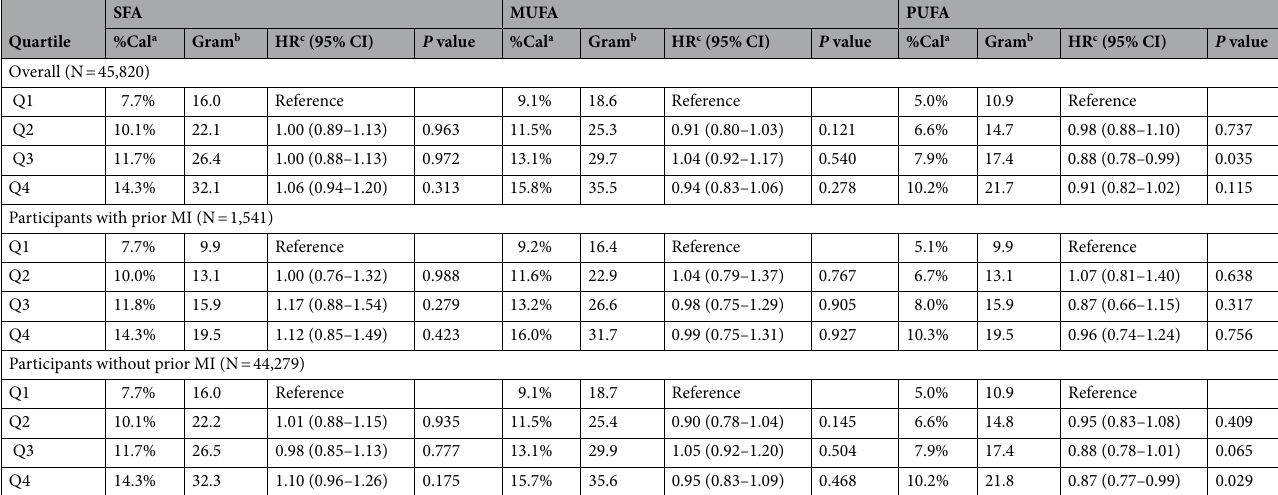
Table 3. Quartiles of the percentage of calories from usual intake of fatty acids and risk for heart disease mortality among 45,820 adults. a Mean percentage of calories from fatty acids in each quartile. b Mean amount (grams) of fatty acid intake in each quartile. c Adjusted for age, sex, ethnicity, obesity, poverty-income ratio, education, physical activity, alcohol consumption, smoking status, survey period, usual intake of protein (natural log transformed), usual intake of carbohydrate (natural log transformed), systolic blood pressure (natural log transformed), total cholesterol (natural log transformed), and hemoglobin A1c (natural log transformed). CI Confidence interval, HR Hazard ratio, MI Myocardial infarction, MUFA